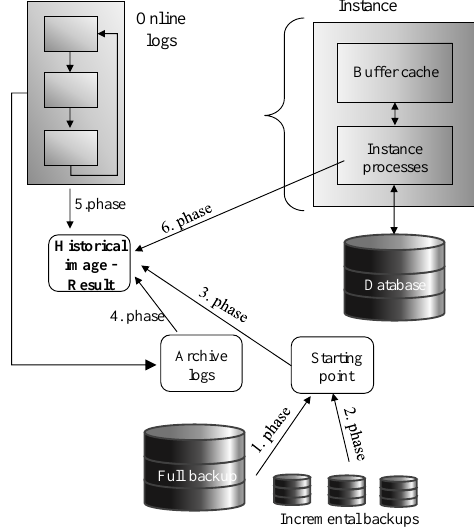
Figure 3. Historical data obtaining process—the backup starting point.